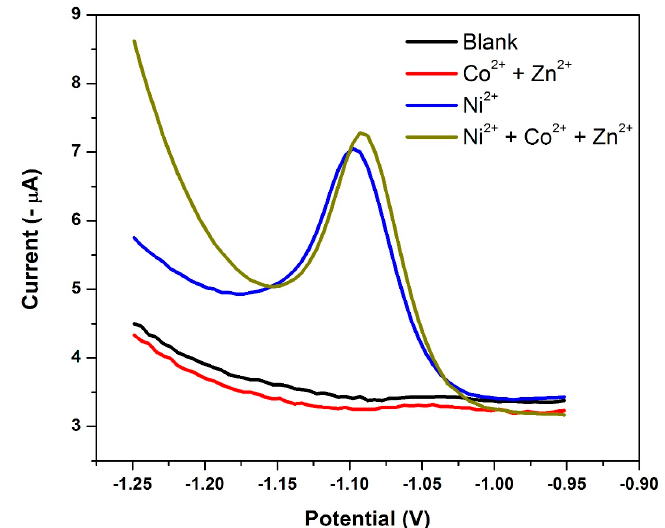
Figure 16. Square-wave voltammograms of 0 µ g L − 1 metal cations (black); 200 µ g L − 1 Co 2+ and Zn 2+ (red); 20 µ g L − 1 Ni 2+ (blue) and 20 µ g L − 1 Ni 2+ in the presence of 200 µ g L − 1 Co 2+ and Zn 2+ (green) at a NGr-DMG-GCE. Supporting electrolyte (0.1 M NH 3 /NH 4 Cl buffer (pH 9.3)), deposition potential ( − 0.7 V), deposition time (120 s), frequency (20 Hz), amplitude (0.02 V) and voltage step (0.005 V).